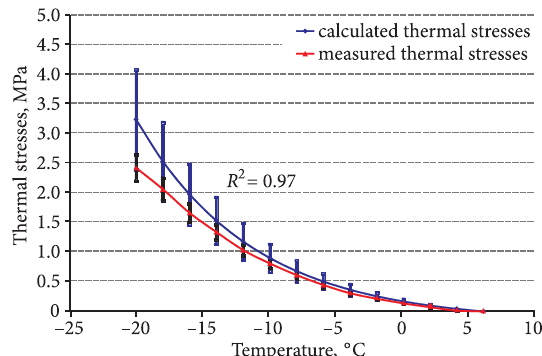
Fig. 6. Calculated and measured thermal stresses in asphalt concrete specimens containing 50/70 plain bitumen